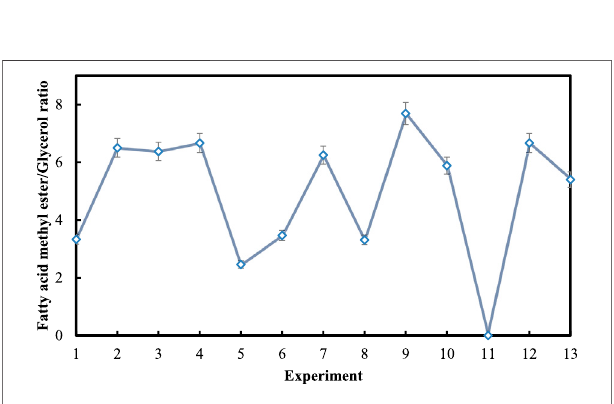
FIGURE 3 | Ratio of fatty acid methyl ester to